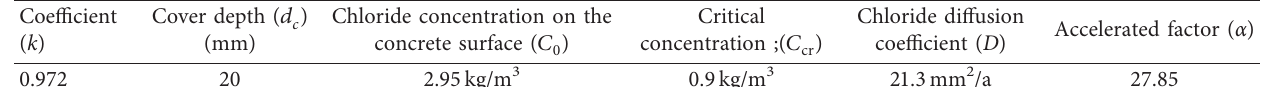
Table 7: Related parameters of prediction model.